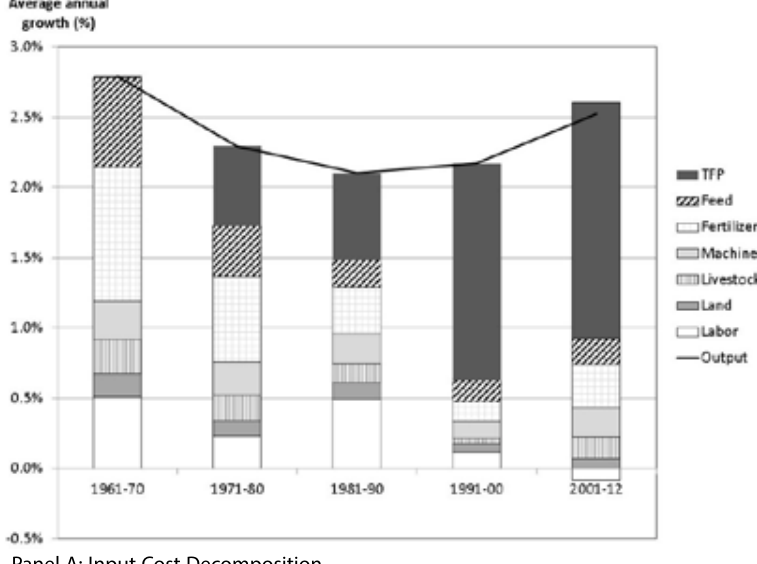
Figure 2. Sources of Global Agricultural